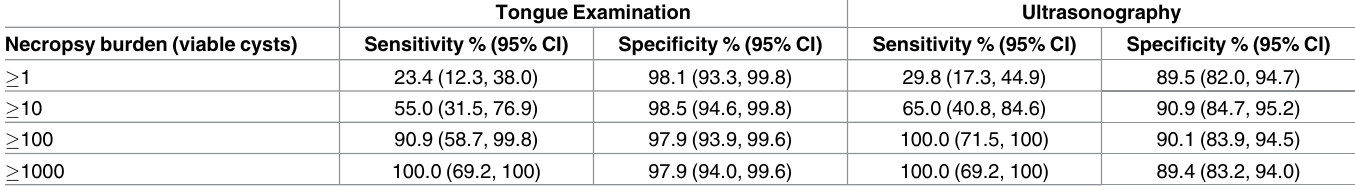
Table 2. Sensitivity and specificity of tongue examination and ultrasonography for detecting pigs with different burdens of viable cysticerci. Tongue